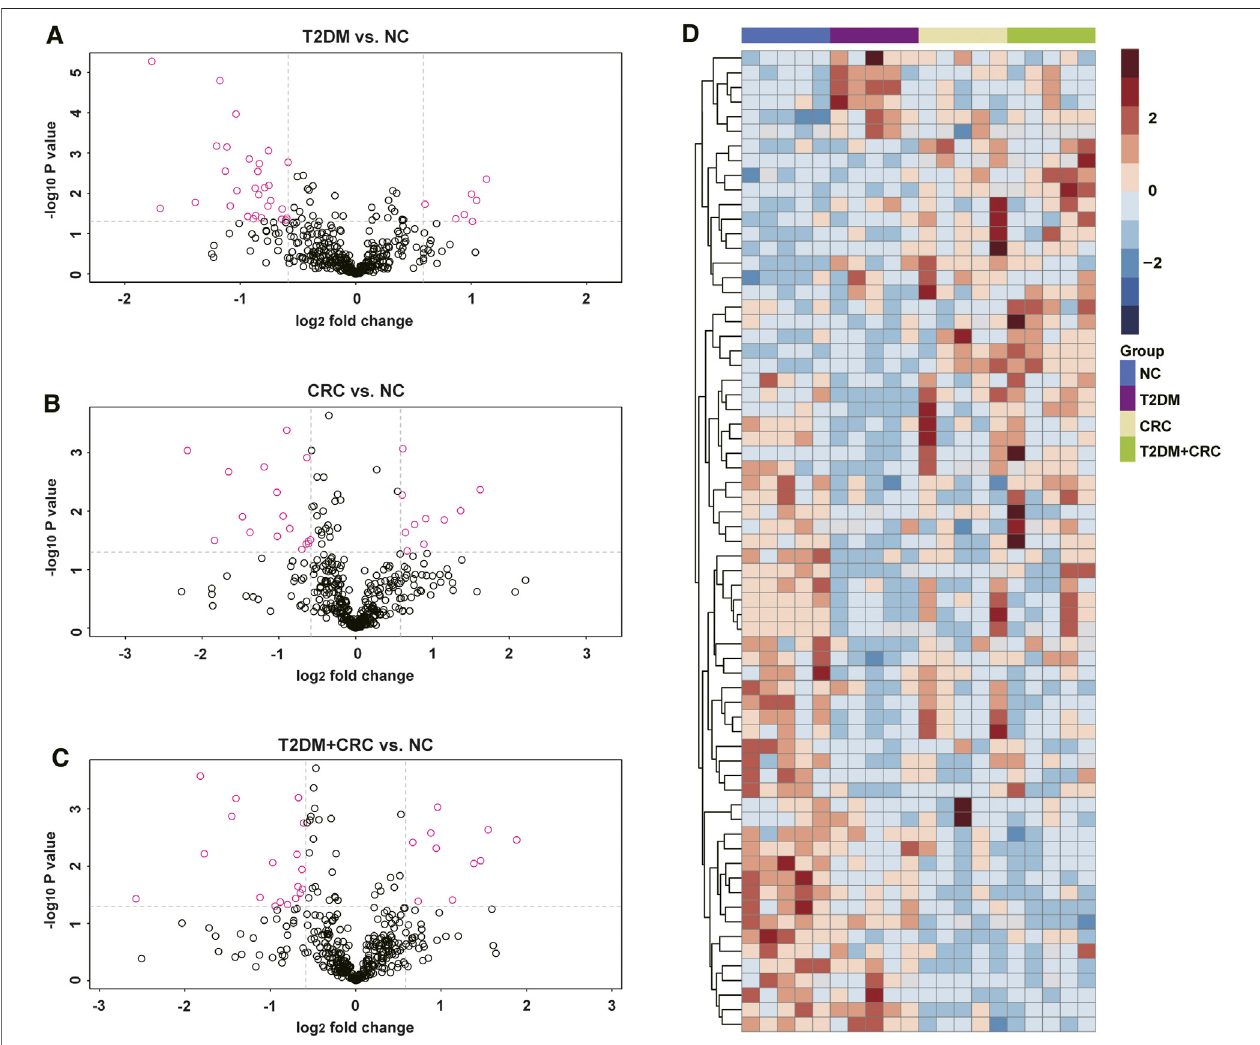
FIGURE 2 | Serum protein pro fi les in patient cohorts in the current study. (A – C) Volcano plot exhibiting the DAPs in the T2DM, CRC and T2DM + CRC patients in comparisonwithhealthyparticipants.DAPswereextractedusingRlanguage4.0.0withacriterionoffoldchange(FC) ≥ 1.50or ≤ 0.67andunpaired t -test p value ≤ 0.05. (D) Hierarchical cluster analysis of the 67 DAPs in the groups of healthy participants, T2DM, CRC, and T2DM + CRC. There were fi ve samples in each group. Red represents for high expression and blue represents for low expression.